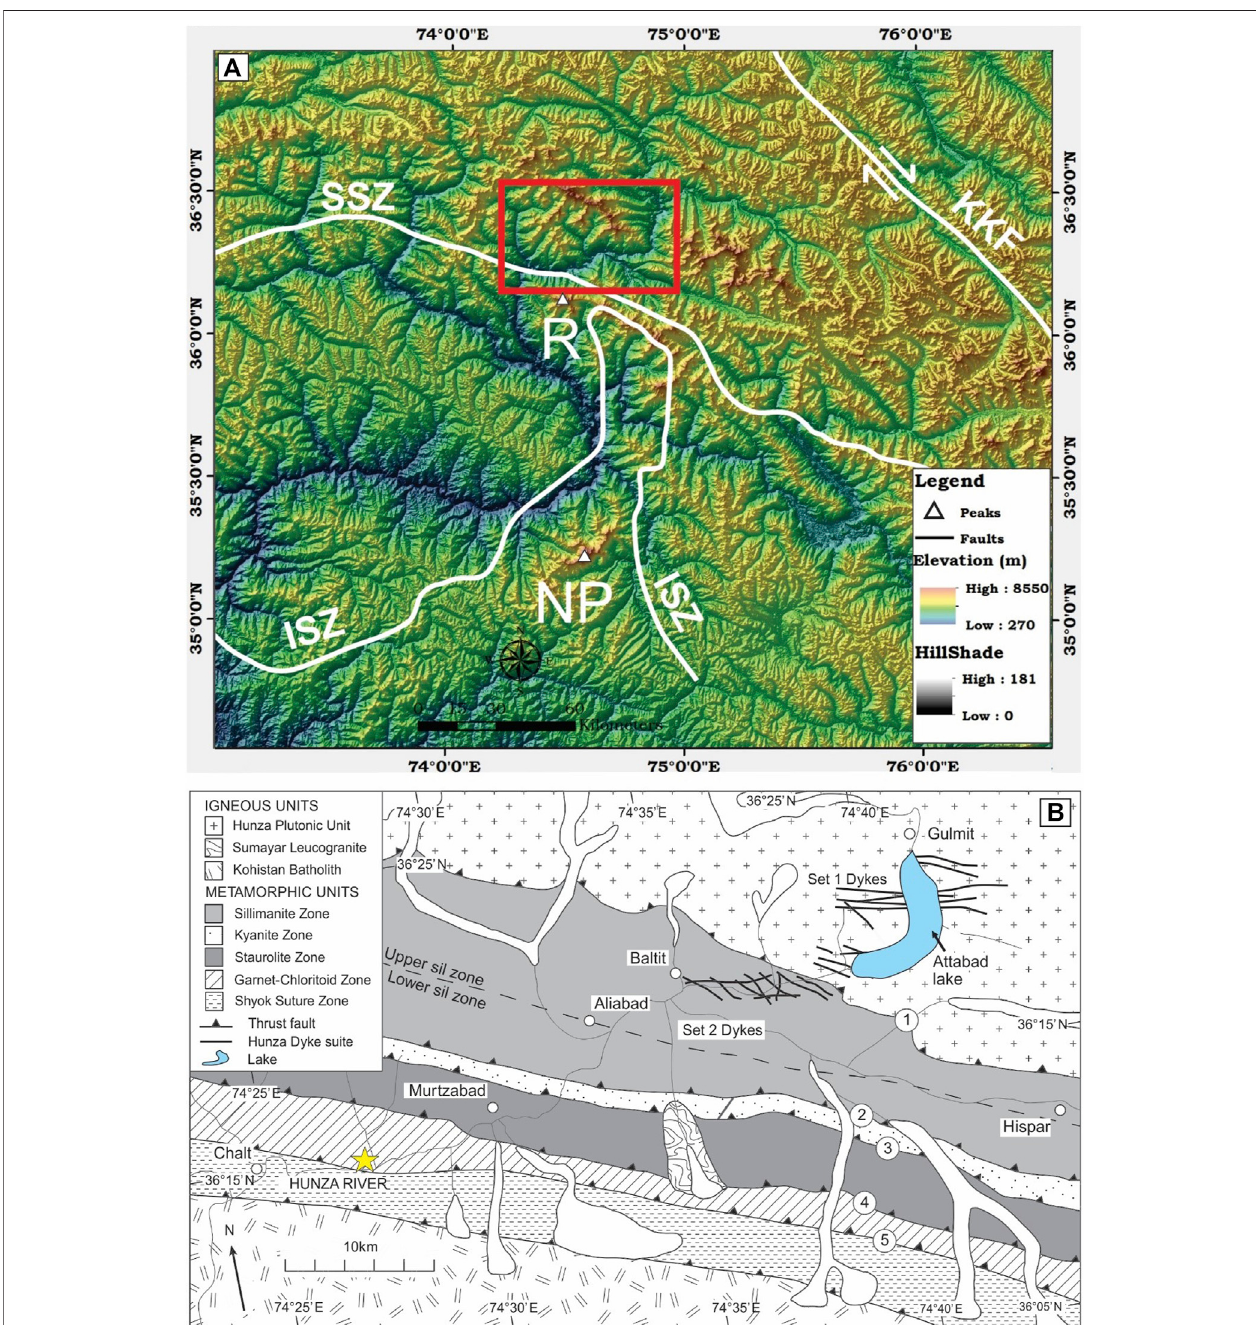
FIGURE 1 | (A) Digital Elevation Model (DEM) with shaded-relief of northern Pakistan showing the location of the major faults. The red box denotes the location of Panel 1 (B) . ISZ: Indus Suture Zone; SSZ: Shyok Suture Zone; KKF: Karakoram Fault; NP: Nanga Parbat; R: Rakaposhi. Panel 1 (B) geological map of the Hunza Valley showing tectonic relations. The locality of the study site is marked with a yellow star. Thrusts dividing segments of the Karakoram metamorphic complex are numbered: 1, Hunza; 2, Hassanabad; 3, North Murtzabad; 4, South Murtzabad; 5, MKT (after Palin et al., 2012).